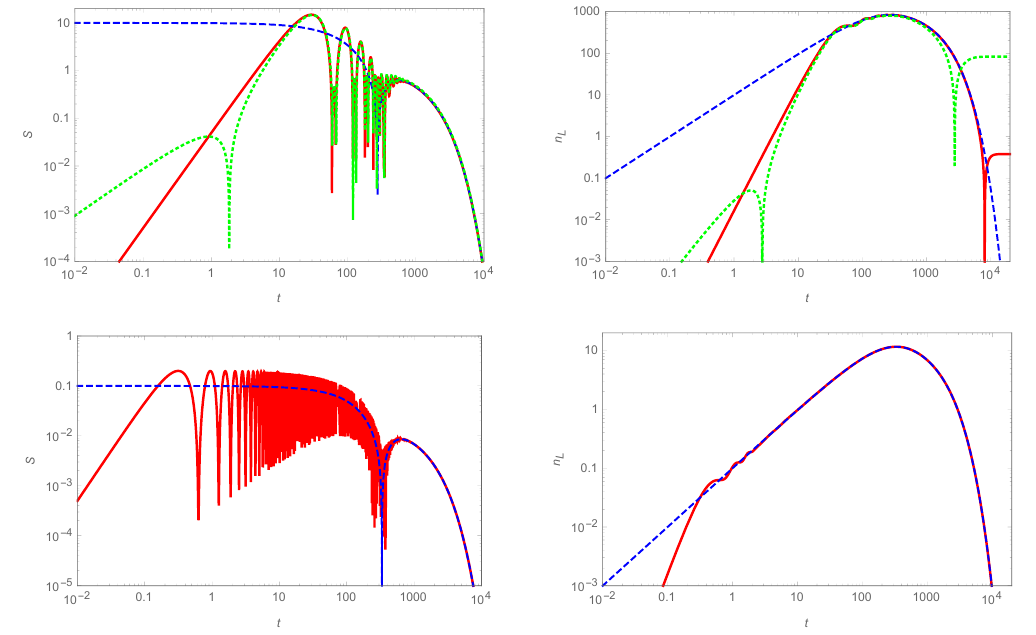
Figure 1 . Source term (left plots), and lepton asymmetry (right plots), as a function of time nor- malized to γ/M , with Γ 1 /M = 1 / 100 , Γ 2 /M = 1 / 120 , and ∆ M/M = 0 . 1 (10) in the top (bottom) plots. The lepton asymmetry has been obtained integrating only the source term (washouts are not considered). The solid red line corresponds to the source S ( T ) from eq. (4.5), the dashed blue line to the source of the classical BE in the hierarchical limit (eq. (4.9)), and the green dotted one to the source S ( t ) without including the interference terms (in the bottom plots the green curves are not shown because they are almost identical to the red ones). The scale on the vertical axis is not relevant and we have taken, for the purpose of illustration, n eq ( t ) = e − M t/ (1000 γ ) (after a change of variables in the integration over time, the factor M/γ becomes part of the normalization chosen for the lepton